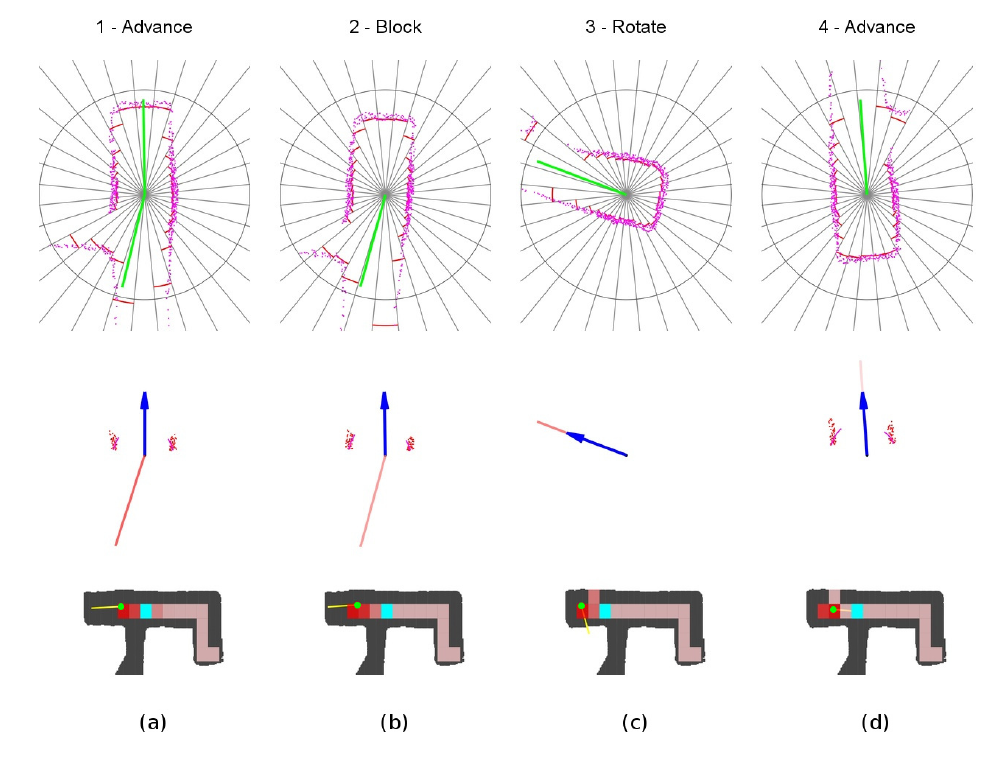
Figure 18. Dead end secuence of events ( a ) Location 1. ( b ) Location 2. ( c ) Location 3. ( d ) Location 4.